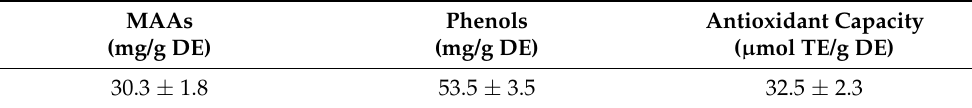
Table 3. Content of MAAs and phenolic compounds, and antioxidant capacity in the PCE. MAAs (mg/g